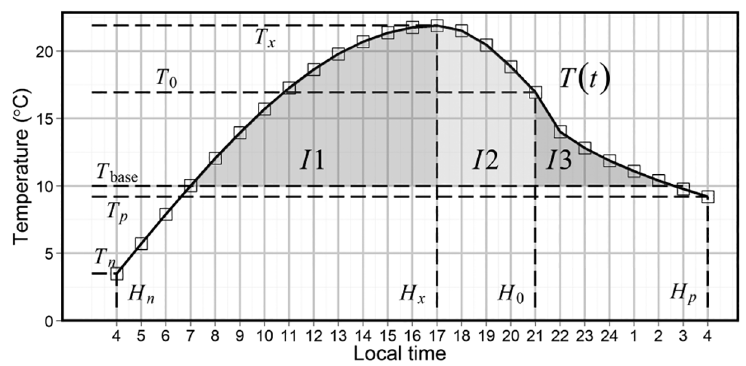
Fig. 3. Sample diurnal temperature cycle and GDD calculation, adapted from Cesaraccio et al.